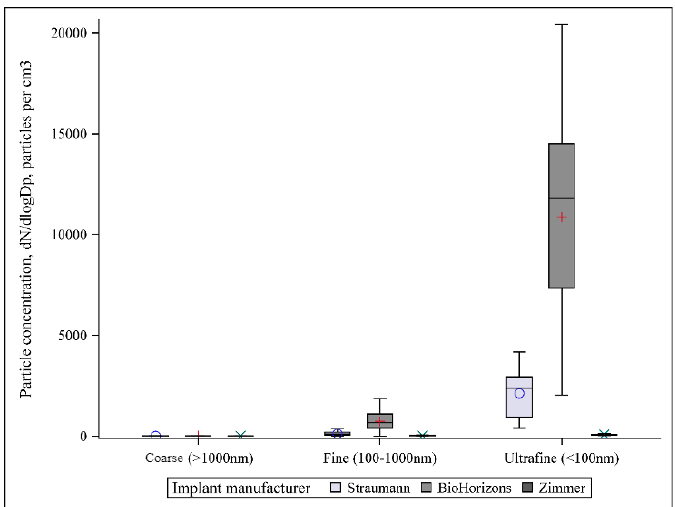
Figure 4. The mean particle number concentration from SMPS & APS stratified by particle size. Dot plots were created to indicate mean particle number concentration stratified by minute. The first minute of the procedure generated a higher number concentration compared to the second and third minutes for all implant systems, especially for Group A (Straumann) and Group B (BioHorizons) (Figure 5A–C).